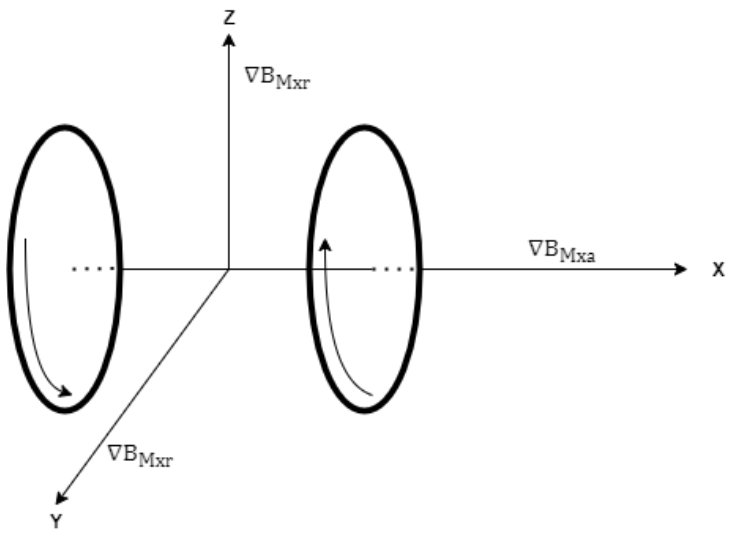
Figure 4. Axial and radial components of the gradient magnetic